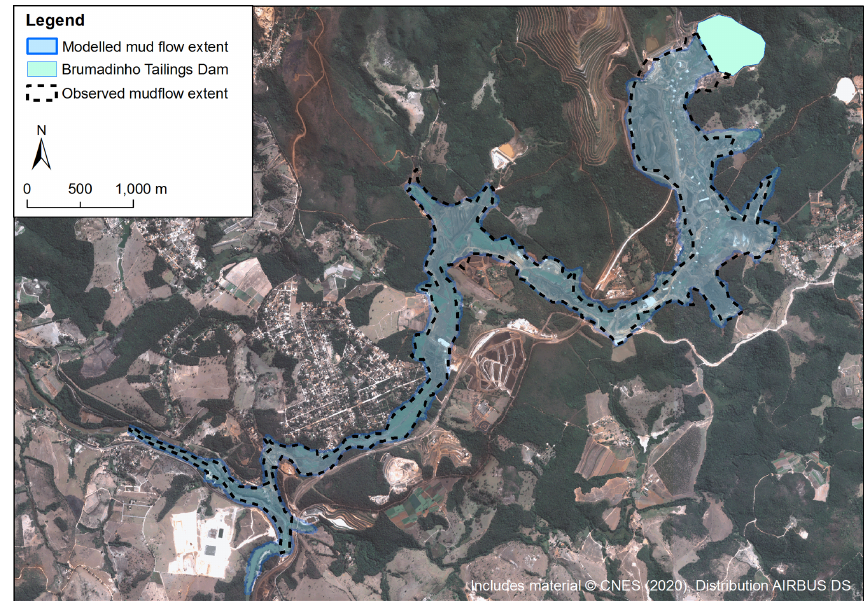
Figure 7. Comparison of the maximum modelled mud extent and the observed maximum mud extent downstream of the Brumadinho tailings dams.